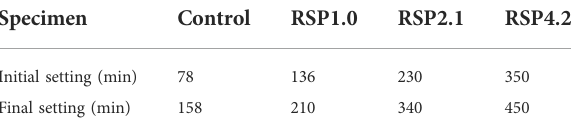
TABLE 3 Setting times of AAS